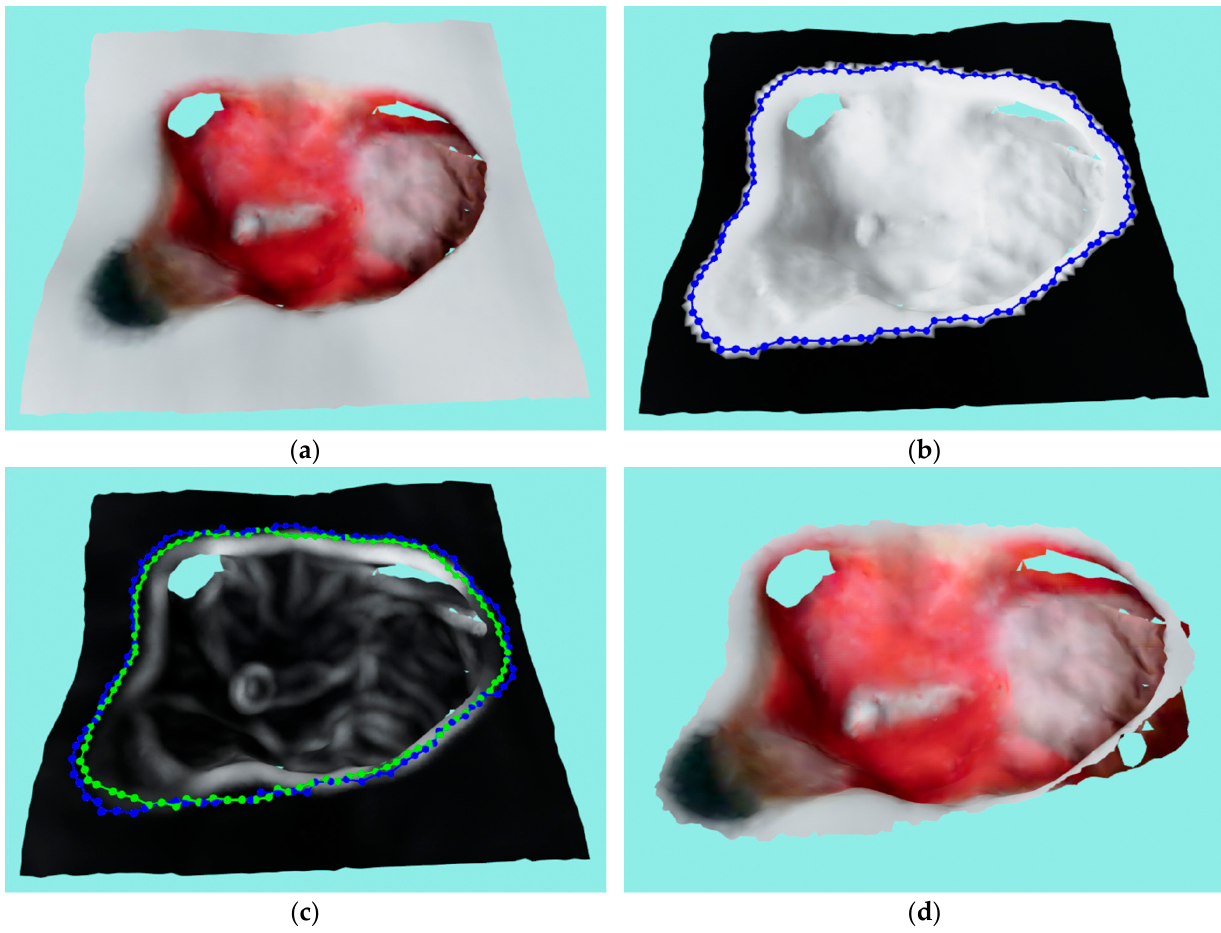
Figure 18. Case study for stage 4 pressure ulcer: (a) input wound mesh; ( b ) masked wound mesh with initial contour; ( c ) wound mesh with curvature texture and initial and final contours shown in blue and green colors, respectively; ( d ) fi nal cut wound mesh model.